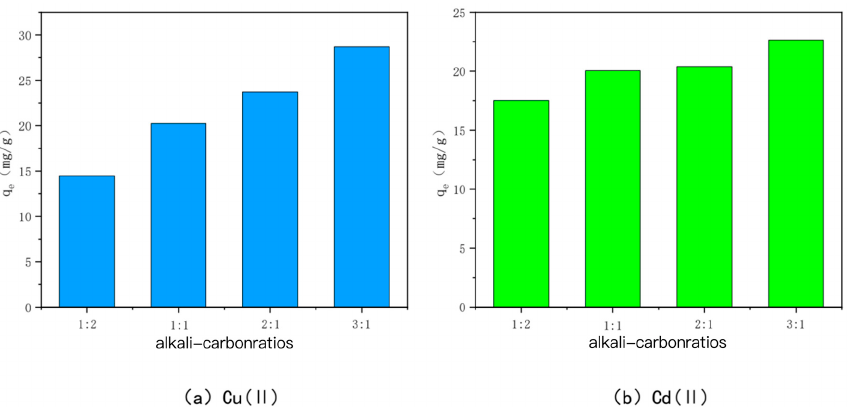
Figure 3. The adsorption capacity of Cu(II)/Cd(II) by KOH-activated modified carbon at various alkali-to-carbon ratios.